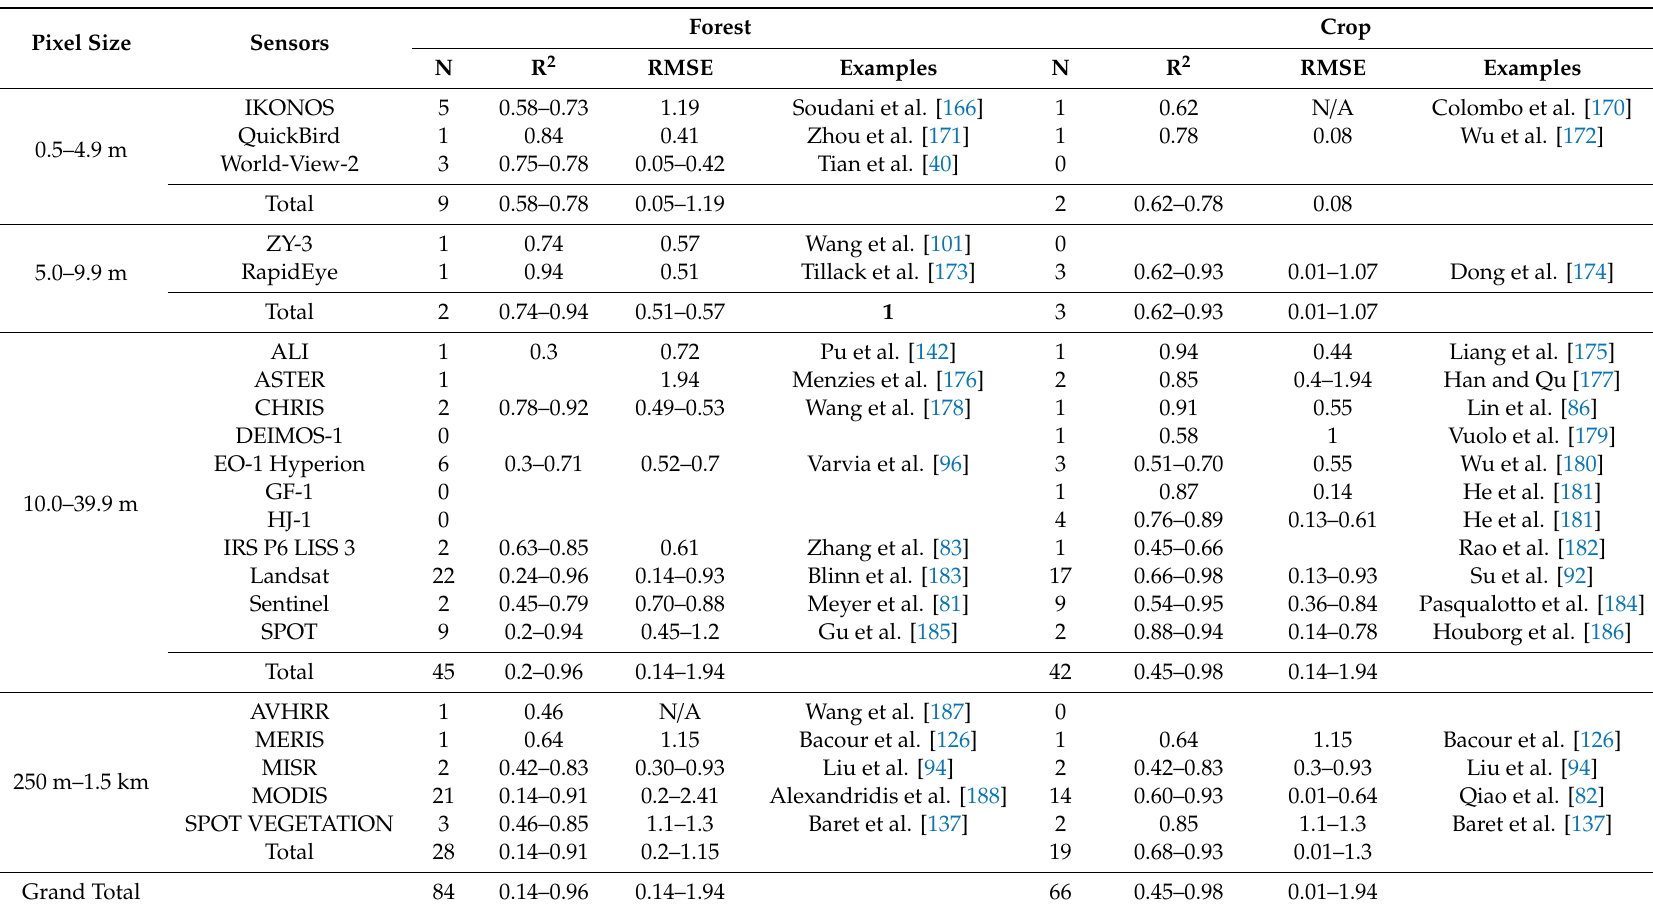
Table 5. The performance of single satellite-based passive remote sensing data sources with di ff erent pixel size for forest and crop LAI estimation. Pixel